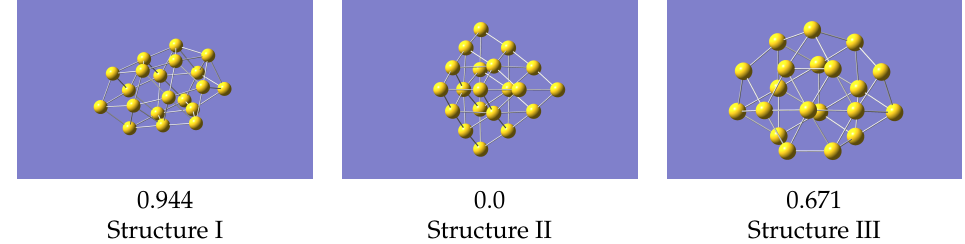
Figure 5. LAMMPS optimised structures using the machine learned potential. Energies (in eV) given relative to the lowest energy structure.